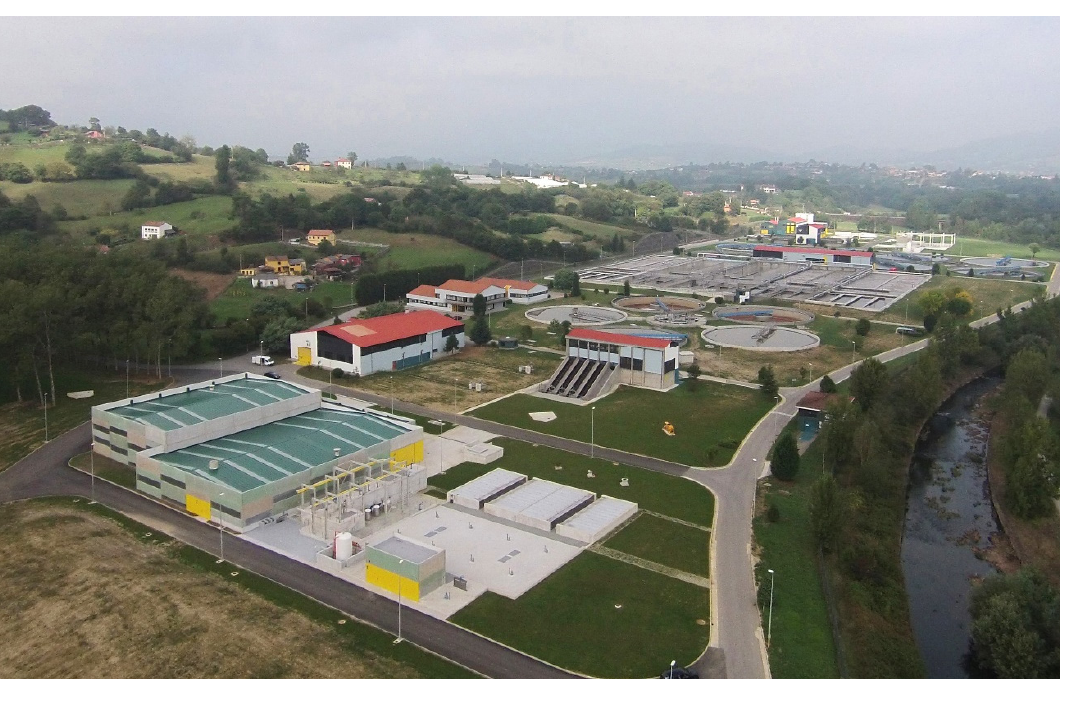
Figure 1. View of the wastewater treatment plant (WWTP) of Villapérez (Asturias, Spain).